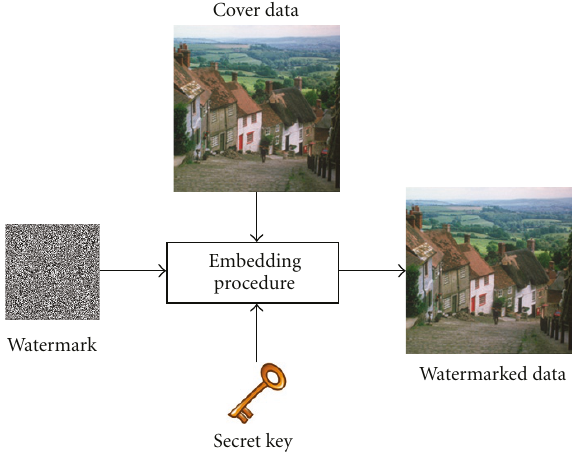
Figure 1: General watermarking